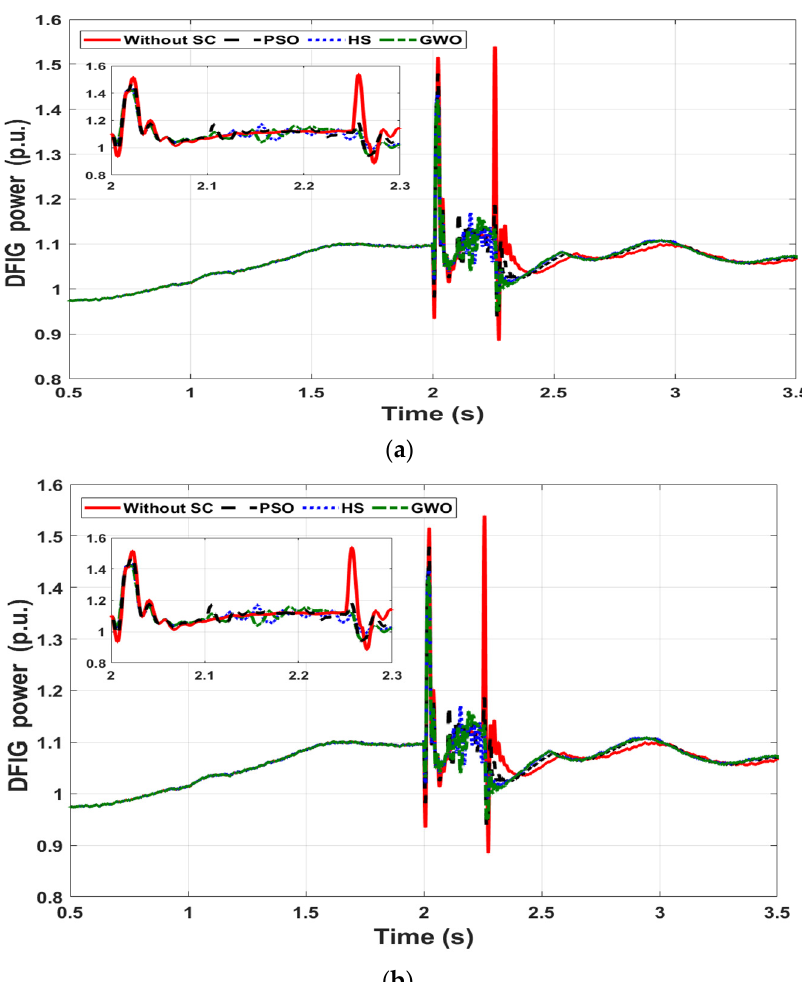
Figure 7. DC-link voltage during the voltage swell case study.